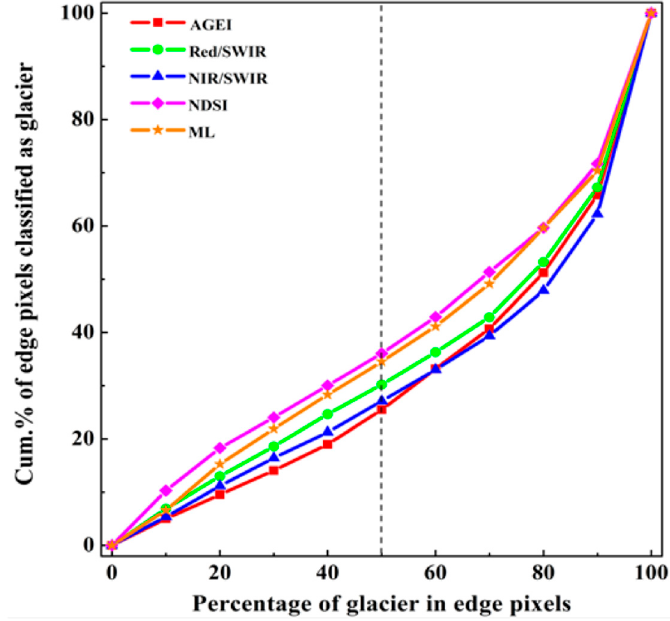
Figure 9. Cumulative frequency of mixed pixels classified as glacier.